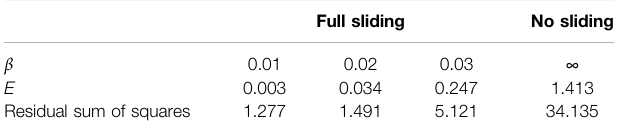
TABLE 4 | Residual sum of squares of the difference between the measured and simulated velocities below 3,950 m.